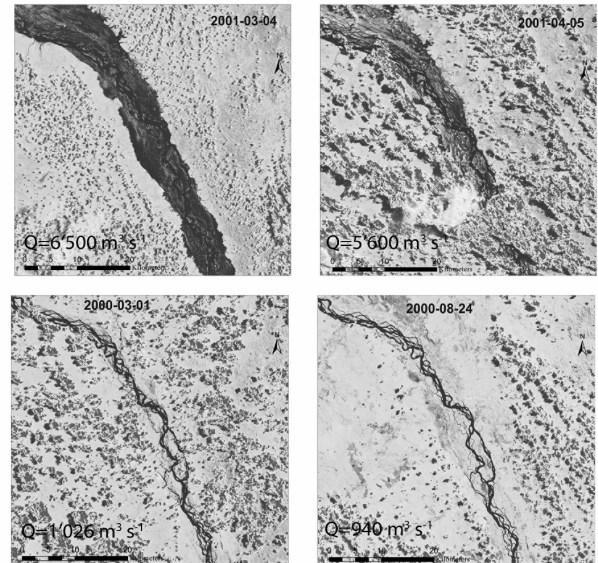
Figure 3. Example of satellite images of the lower Zambezi River upstream Caia (Mozambique): variation of the active river width re- lated to the variation of the river discharge. Discharges vary between 6500m 3 s − 1 and 940m 3 s − 1